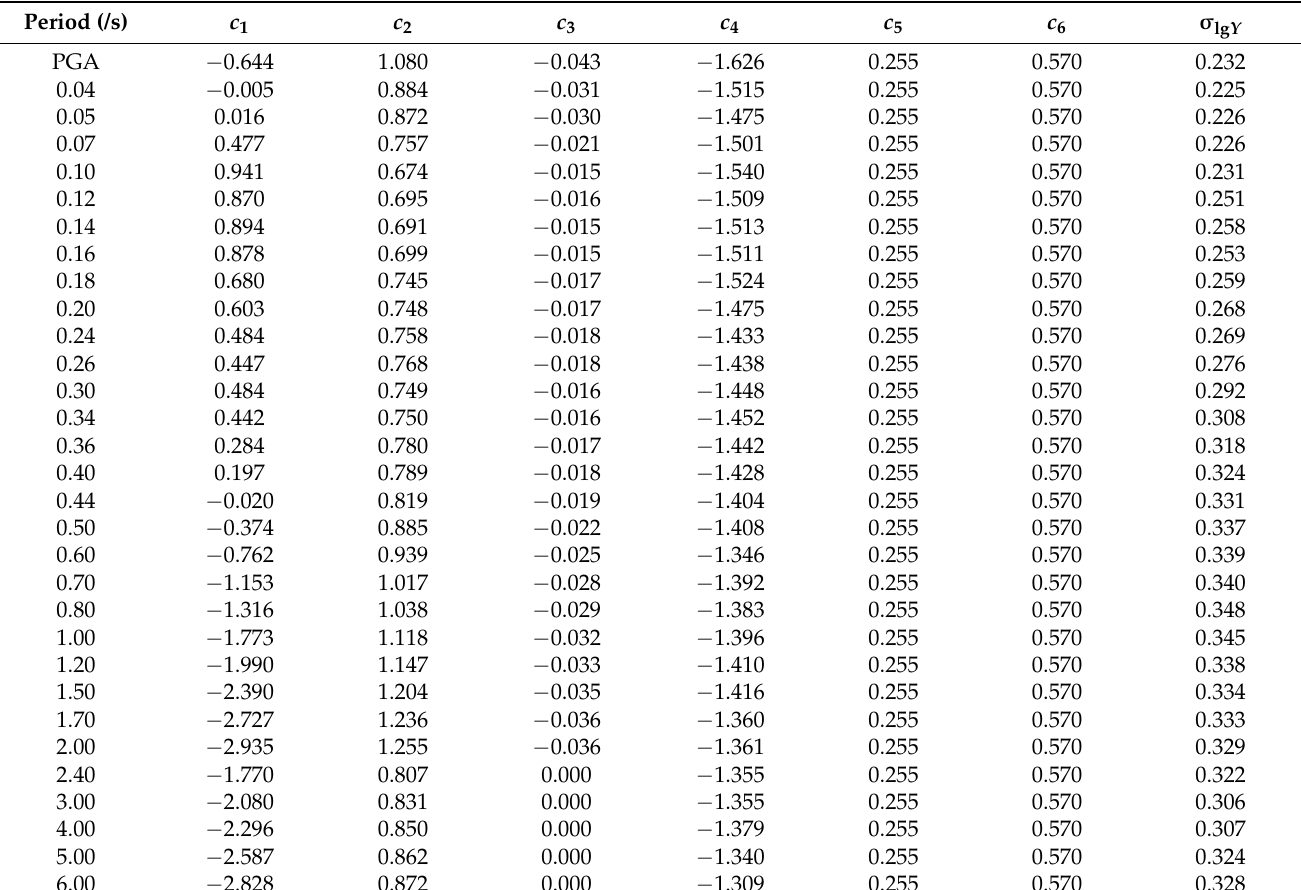
Table 5. Relational coefficient of bedrock ground motion attenuation (minor axis).